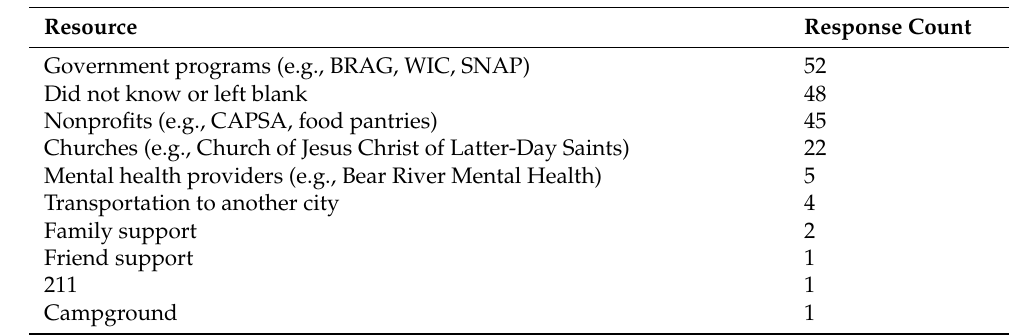
Table 5. Community resources known to landlords. This table shows the resources available to individuals who are facing or are homeless in the Bear River region as named by participating